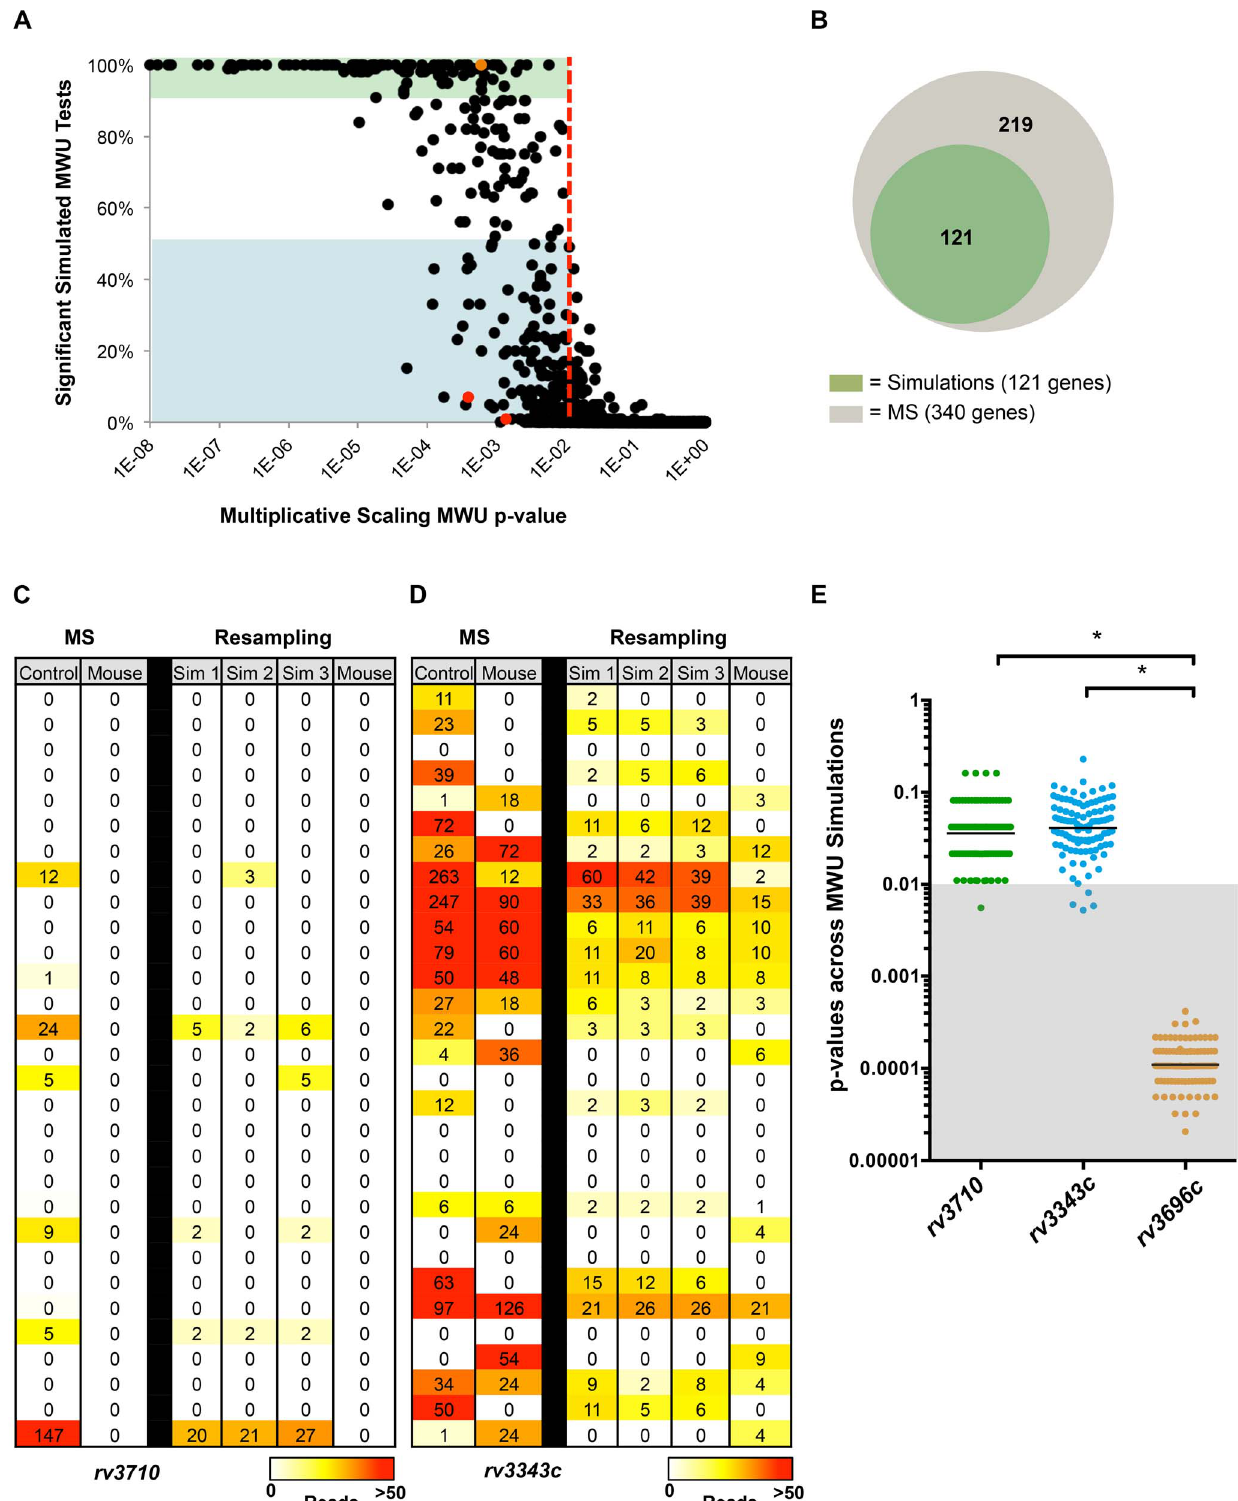
Figure 2. Simulation-based normalization allows identification of loci whose differential read abundance is unlikely to result from genetic drift or sampling error. (A) Two previously published M. tuberculosis datasets from transposon libraries grown in vitro and in a mouse infection model [7] were normalized to the same total reads using multiplicative scaling (MS), and then the genes in each library were compared with a Mann-Whitney U (MWU) statistical test. The same data was also subjected to simulation-based normalization, which models the effect of genetic drift and sampling error in the experiment. Simulation produced 100 new control libraries, which were then used to conduct 100 MWU tests against the mouse-passaged library. Each gene (dot) was then plotted by its MWU p-value derived from MS normalization alone, as well as its reproducibility